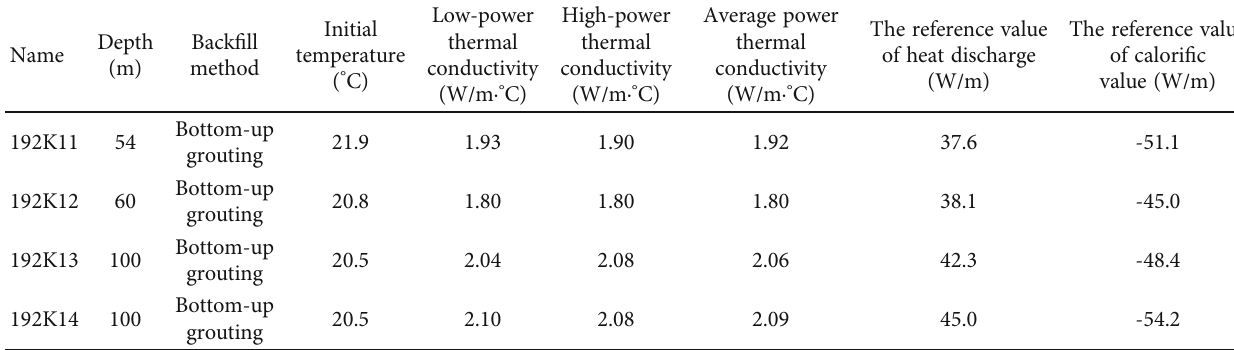
Table 4: Test results of each test hole.